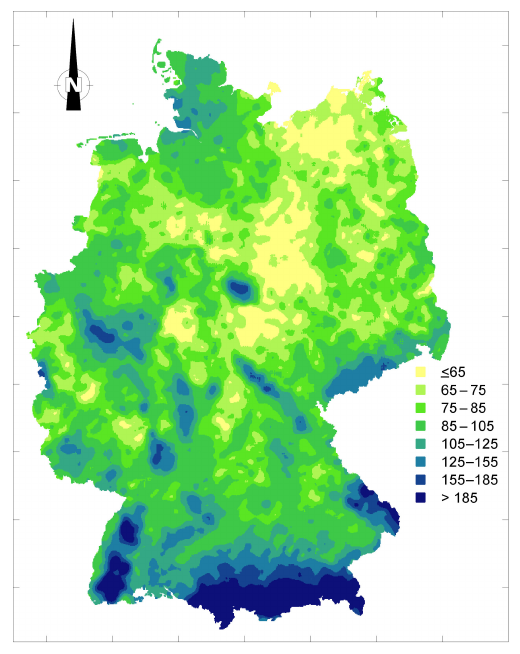
Figure 2. Annual average R factor (Nh − 1 yr − 1 ) map of Germany from 17 years of radar rain data. The axes’ ticks represent distances of 100km. Color classes from yellow to dark blue comprise ap- proximately 10%, 20%, 20%, 25%, 15%, 4%, 3% and 3% of the area, respectively. For a comparison with the Sauerborn (1994) map see Fig. S2 in the Supplement. For comparison with the map before winsorizing and before kriging see Figs. S3 and S4. Average R factors for the 401 local authority areas (average area 893km 2 ) are given in Table